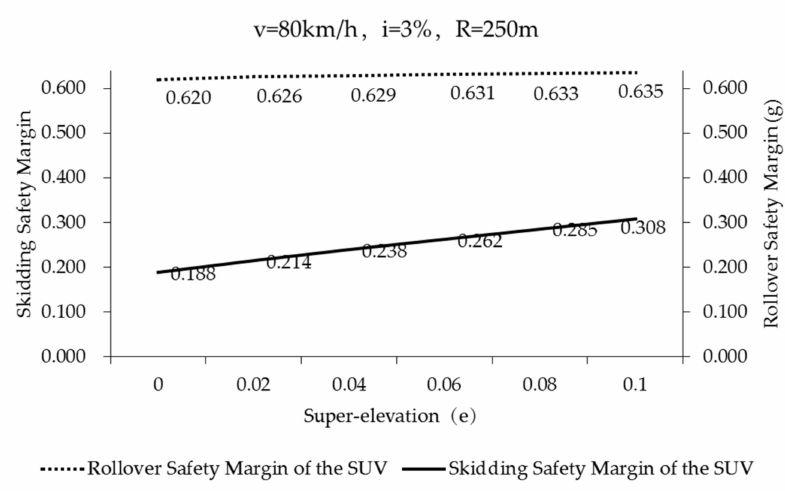
Figure 7. Friction demand of the SUV on good friction